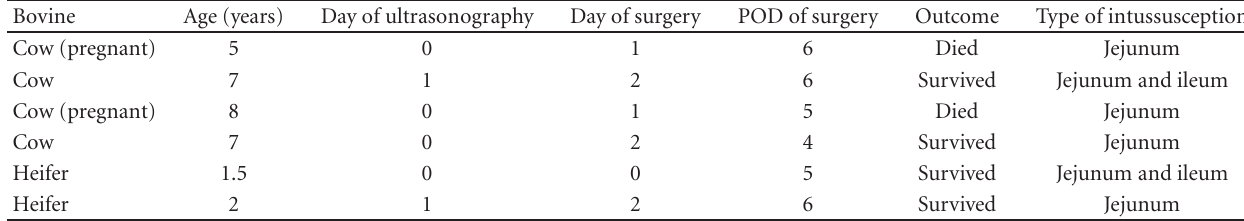
Table 2: Summary of clinical cases of intestinal